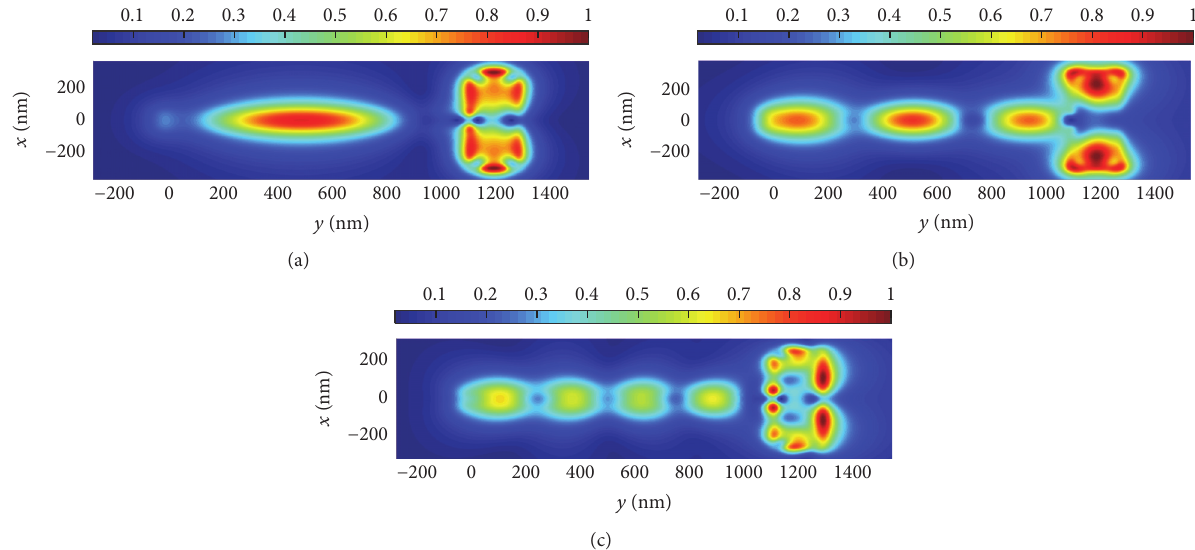
Figure 16: The electric field distribution in the plane 𝑧 = 80 nm, 𝐹 = 100THz (a), 200THz (b), and 300 THz (c), the parameters ℎ 𝑑 = 200 nm, 𝐿 = 1200 nm, 𝑎